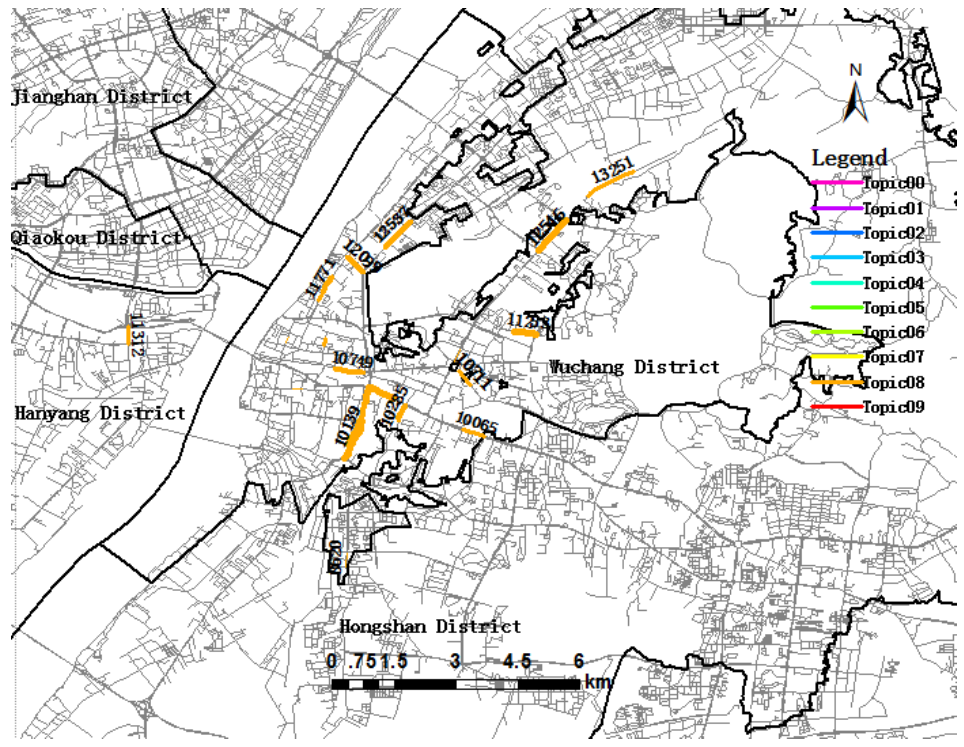
Figure 8. Visualization of trip Topic08 during the morning rush hour period.